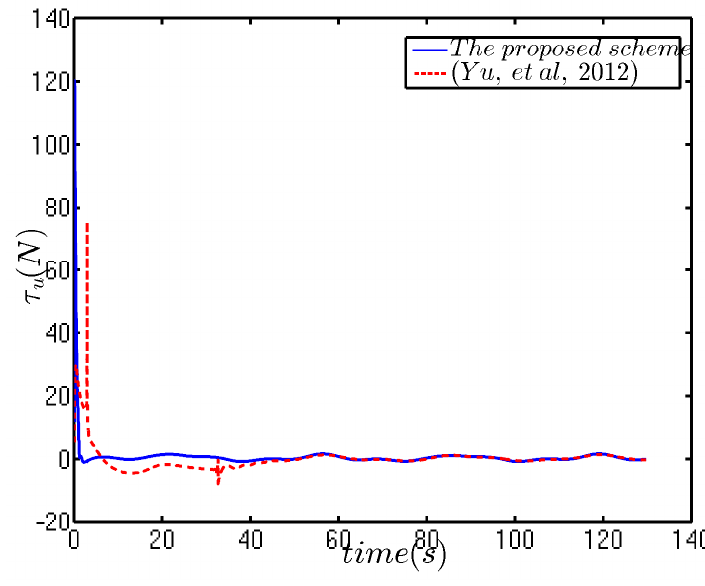
Figure 9. Comparison results of τ u .